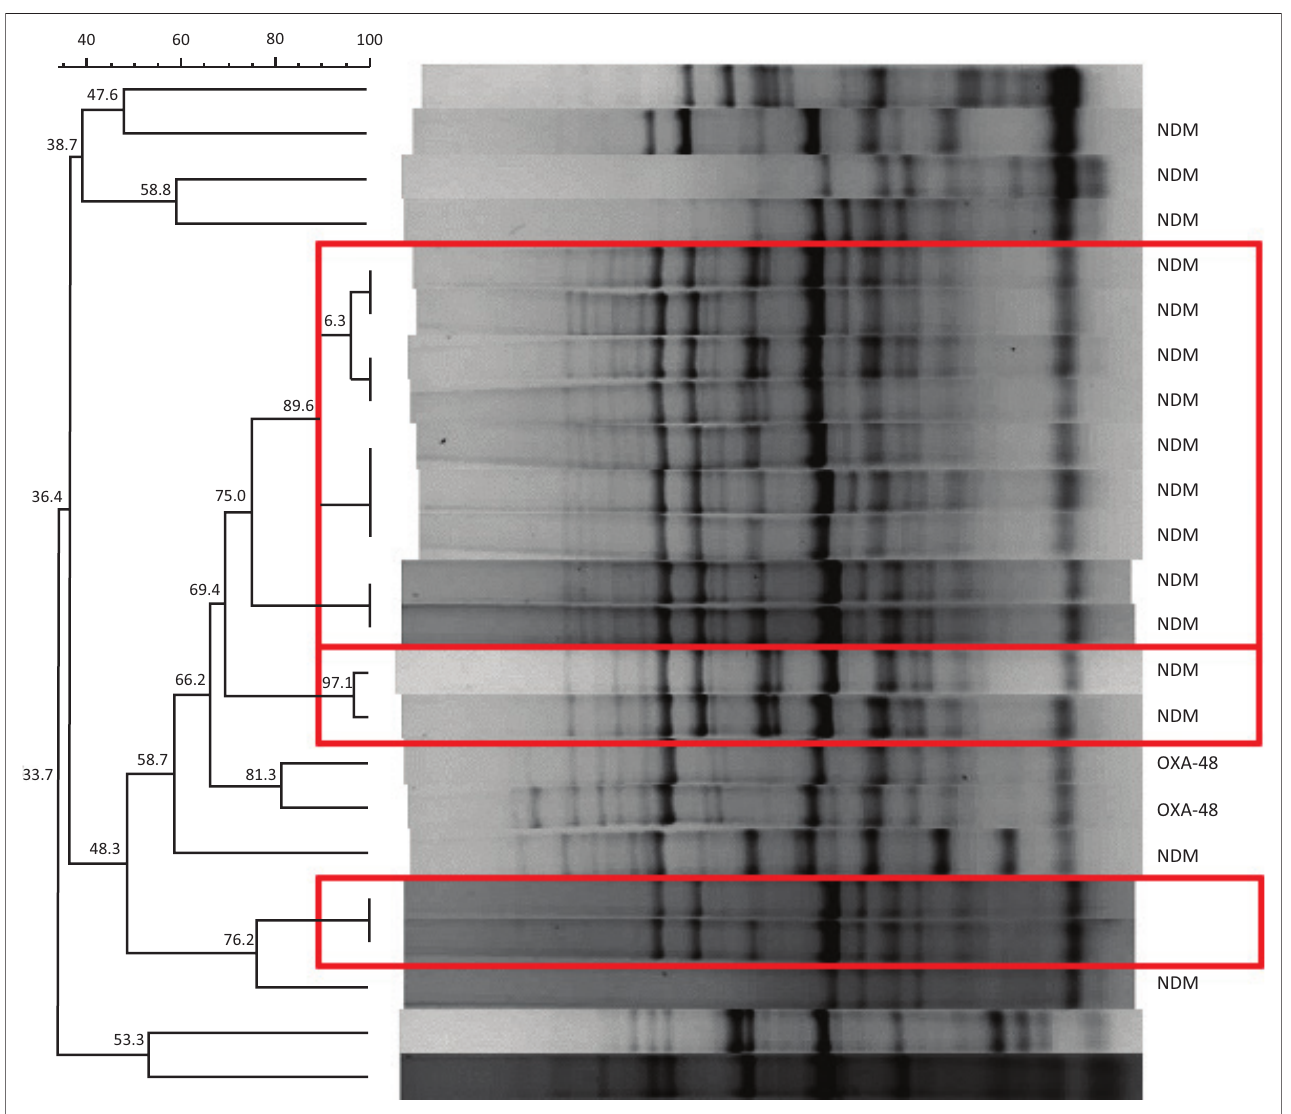
FIGURE 2: Genotypic analysis of 23 neonatal carbapenem-resistant Enterobacterales bloodstream infection